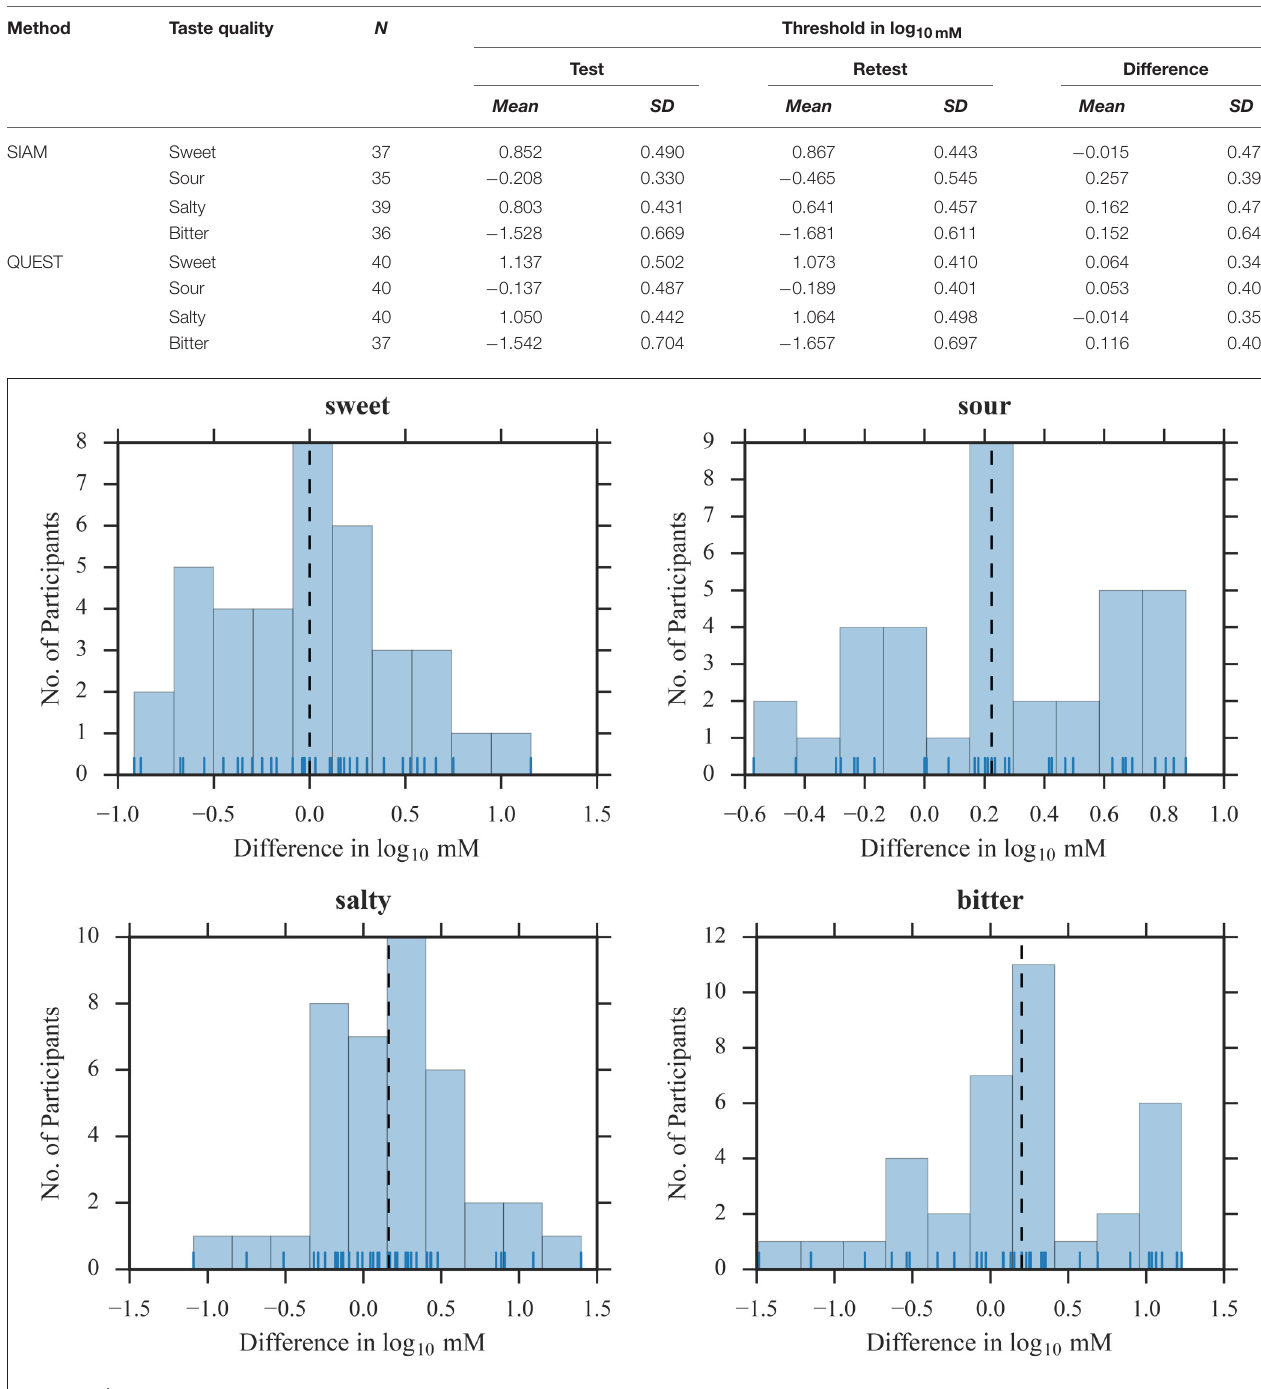
FIGURE 5 | Distribution of threshold differences between test and retest for SIAM. Blue vertical lines depict individual participants; black dashed lines represent the